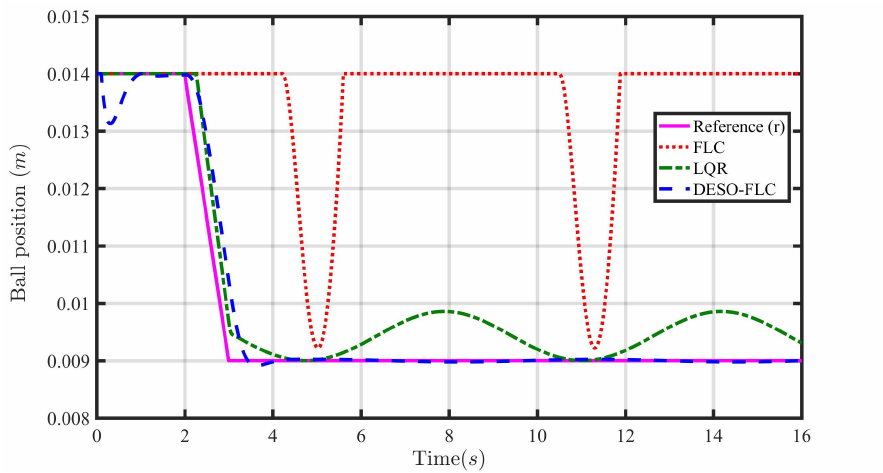
Figure 3. Response of the steel ball position ( x 1 ) in the presence of the payload disturbance ( d ( t ) ).